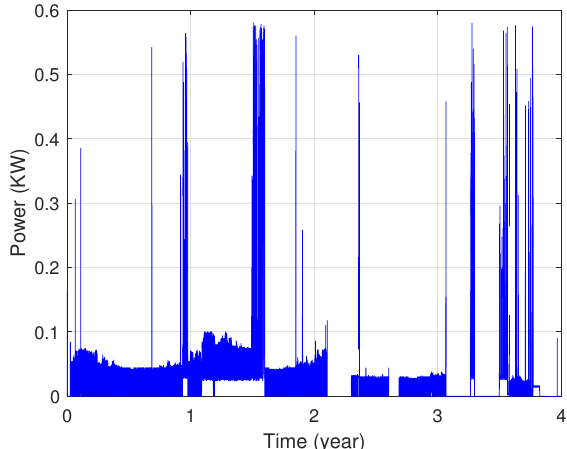
Figure 4. Power consumption of the second